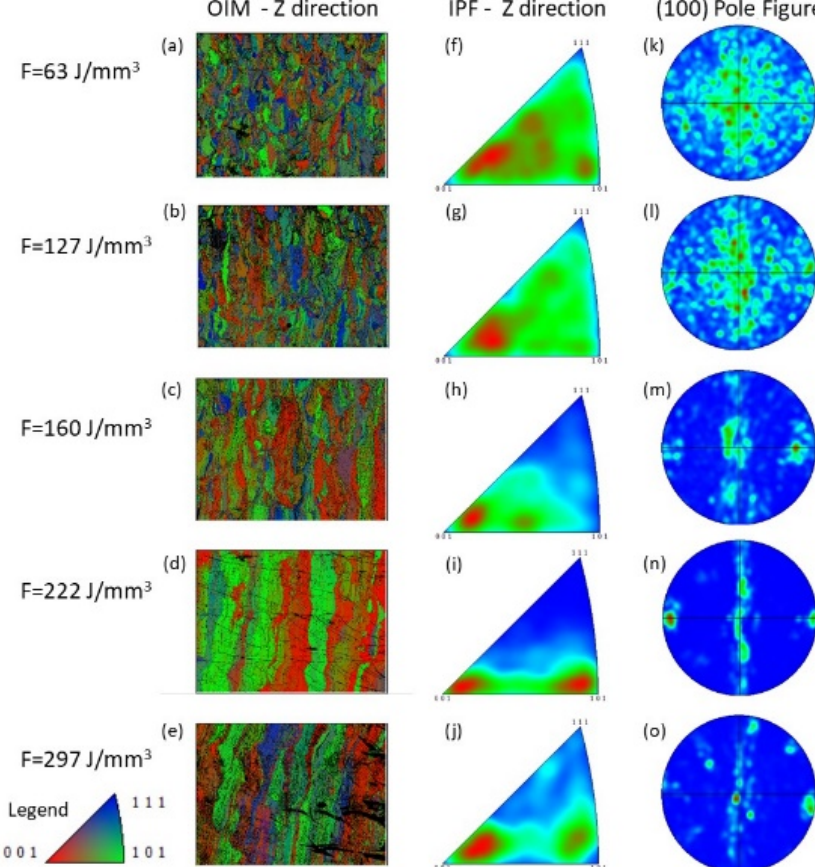
Figure 6. Texture information derived from EBSD analyses of xz section of NiTi samples manufac- tured upon increasing the laser fluence: orientation imaging microscopy ( a – e ), inverse pole figures ( f – j ) according to Z direction, i.e., Building Direction (vertical in the section) and (100) calculated pole figures ( k – o ).